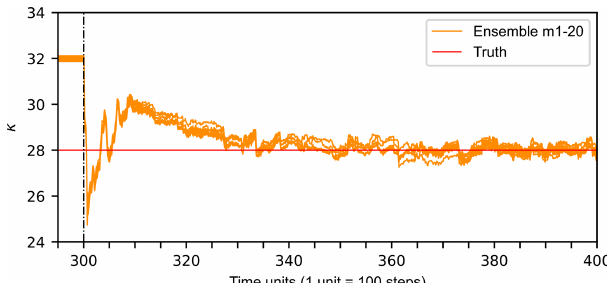
Figure 7. Time series of the overturning rate in one of the ensem- ble members in the free model control ensemble simulations with (red) or without (orange) data assimilation and parameter estima- tion, where κ is erroneously guessed as 31.87768. The dashed black line denoting v = 0 is a division line between the thermal-mode equilibrium state and the haline-mode equilibrium